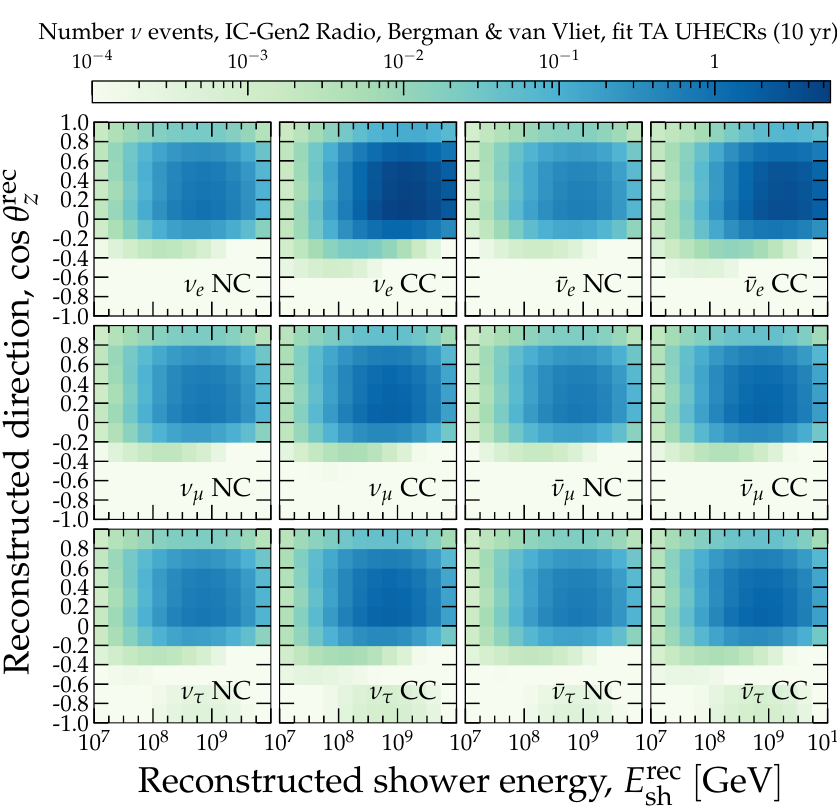
Figure 14 . Mean expected number of neutrino-induced events detected in the IceCube-Gen2 radio array, for the benchmark UHE neutrino flux model 4 [61] (see section 4), separately for NC and CC νN DIS, and for each neutrino species. For this plot, for table 1 and figure 15, and in our main results, we use the baseline choices for the energy and angular resolution, σ respectively. See section 6 for